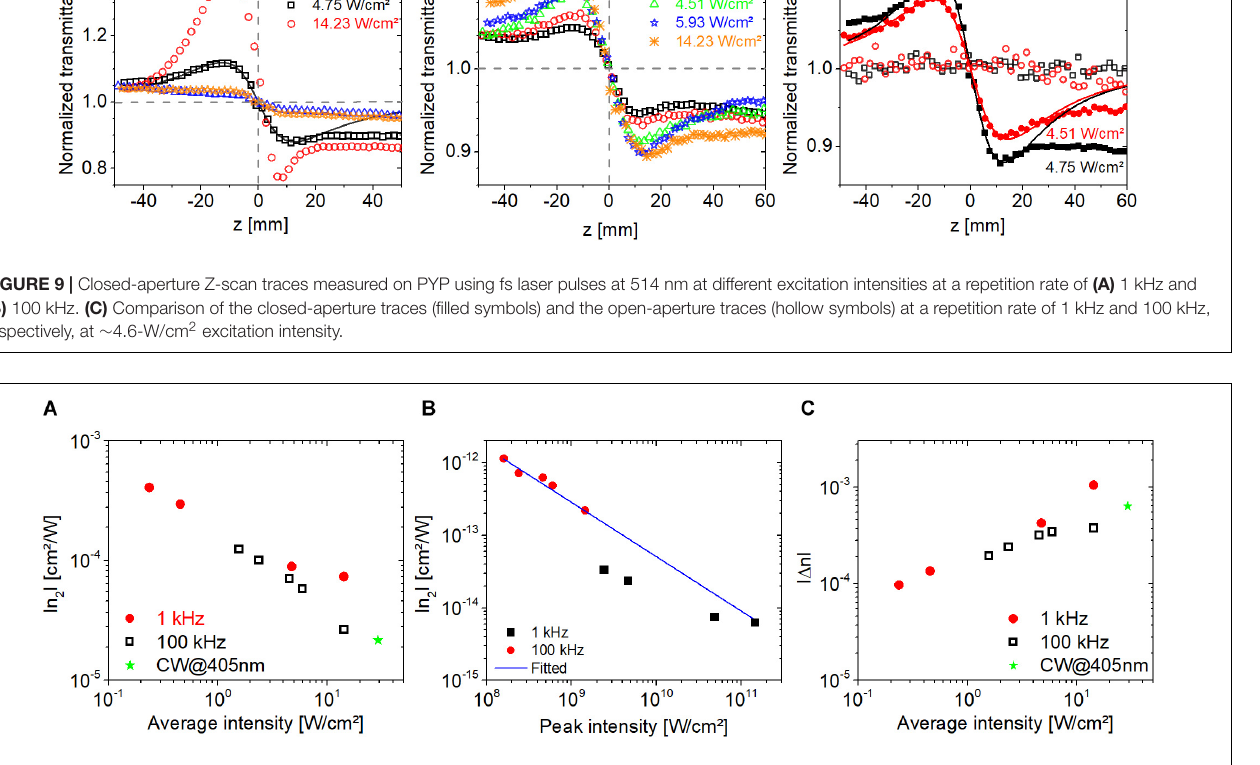
FIGURE 10 | Absolute value of the nonlinear refractive index of PYP at 514 nm as a function of (A) average and (B) peak intensity. (C) The absolute value of the change in the refractive index as a function of average